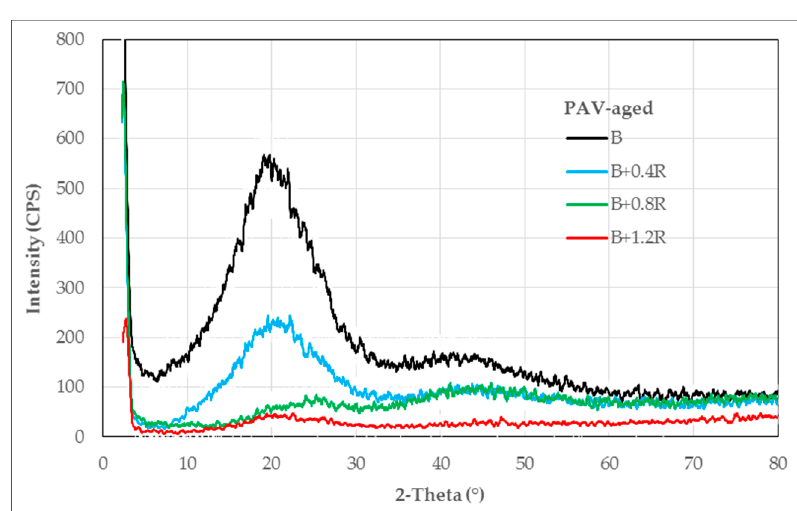
Figure 4. XRD patterns of RTFOT-aged bitumens.